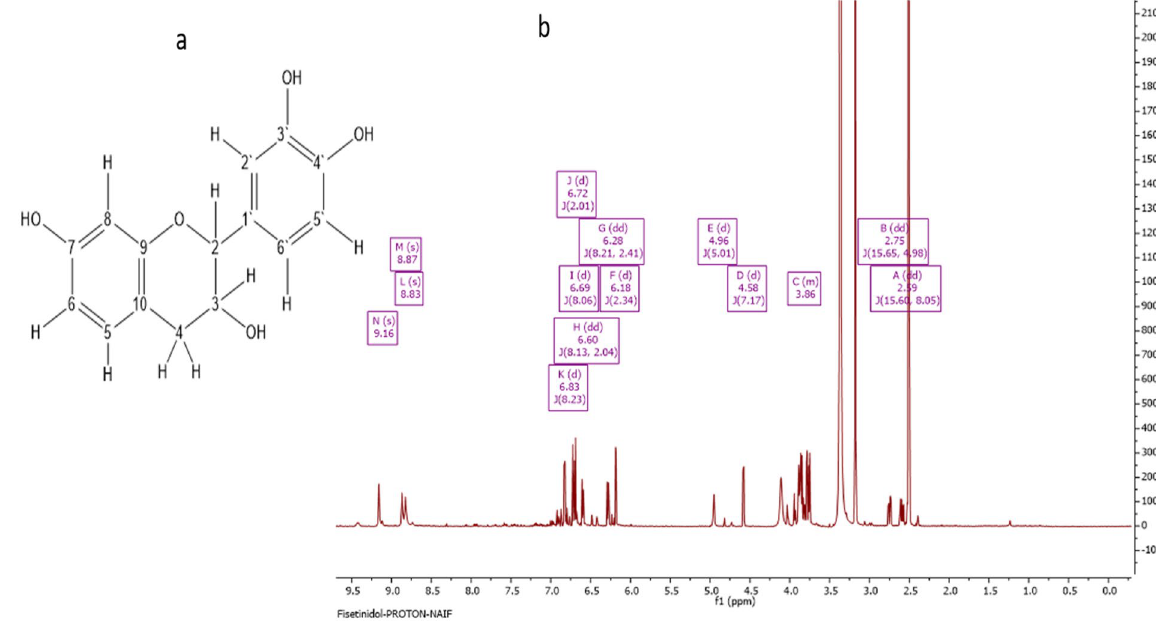
Figure 3. Characterization of S-6-7 as fisetinidol. ( a ) Structure of fisetinidol; ( b ) NMR spectrum of